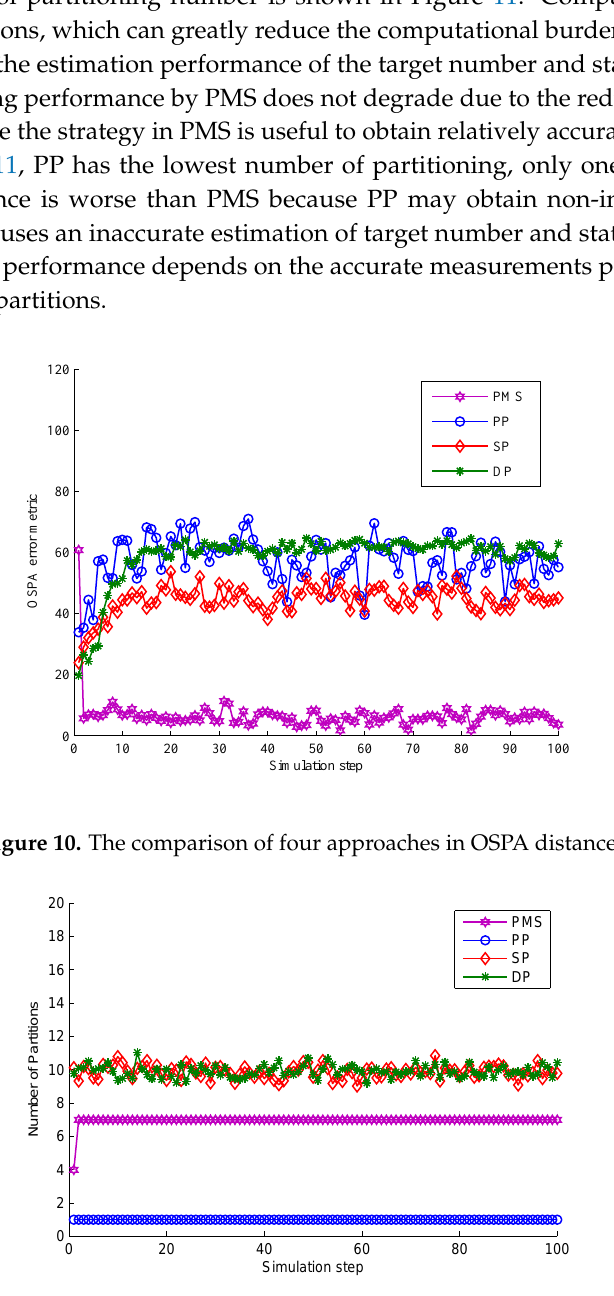
Figure 11. The comparison of four approaches in partitioning